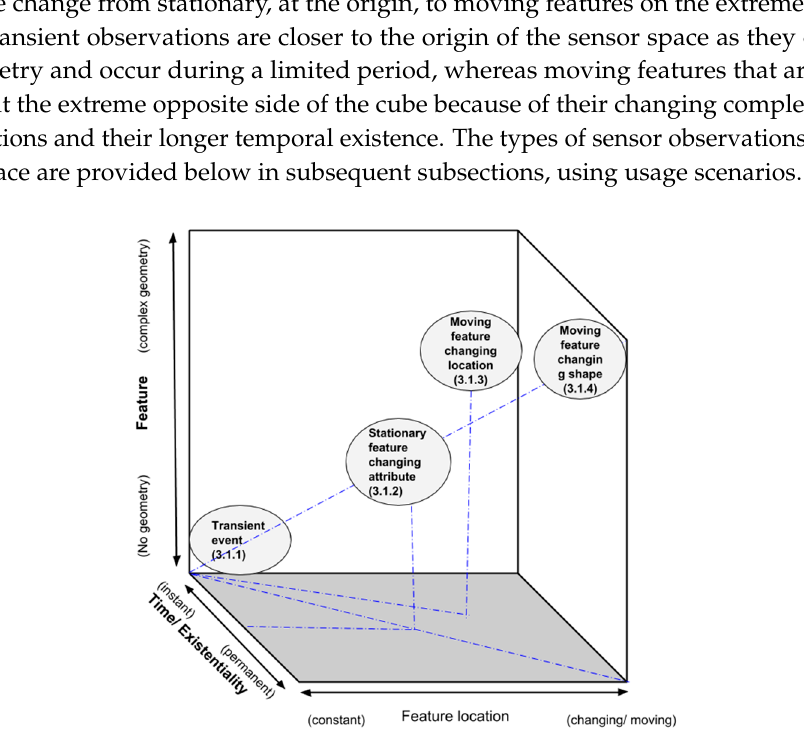
Figure 2. An illustration of the observation types as defined in the “sensor space”.